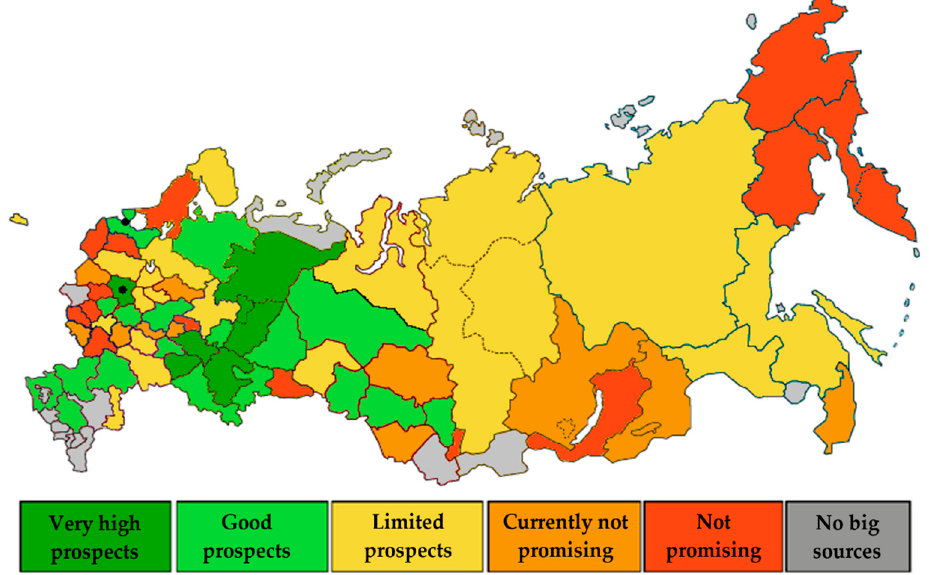
Figure 9. Potential of Russian regions from the viewpoint of CO 2 capture.